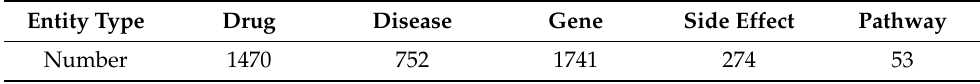
Table 1. The number of entities of each type in the KG for COVID-19. Entity